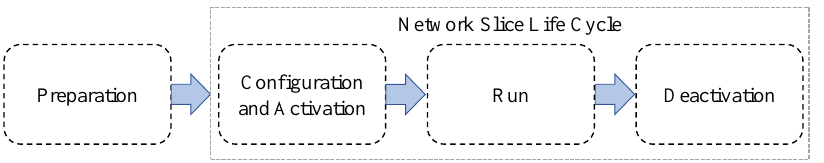
Figure 4. Network slice life